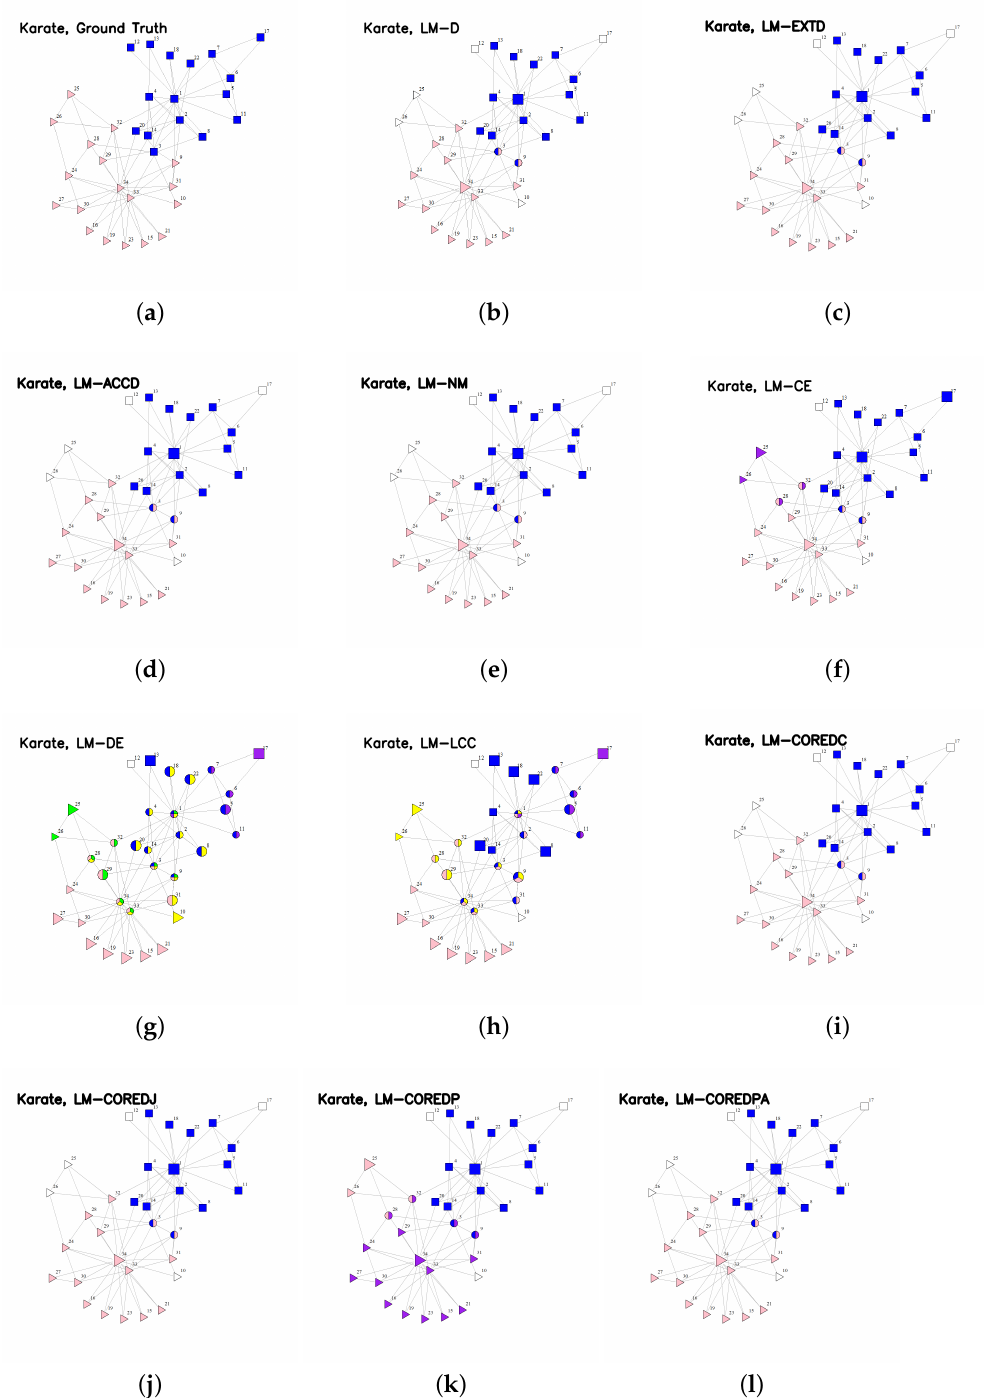
Figure 2. Visualization of the communities resulting from different local seeding algorithms for the Karate network. The two ground-truth communities are distinguished by squares and triangles. Members of the same detected community are marked with one color, and overlapping members are indicated by circles with several colors corresponding to the communities to which they belong. White nodes do not belong to any